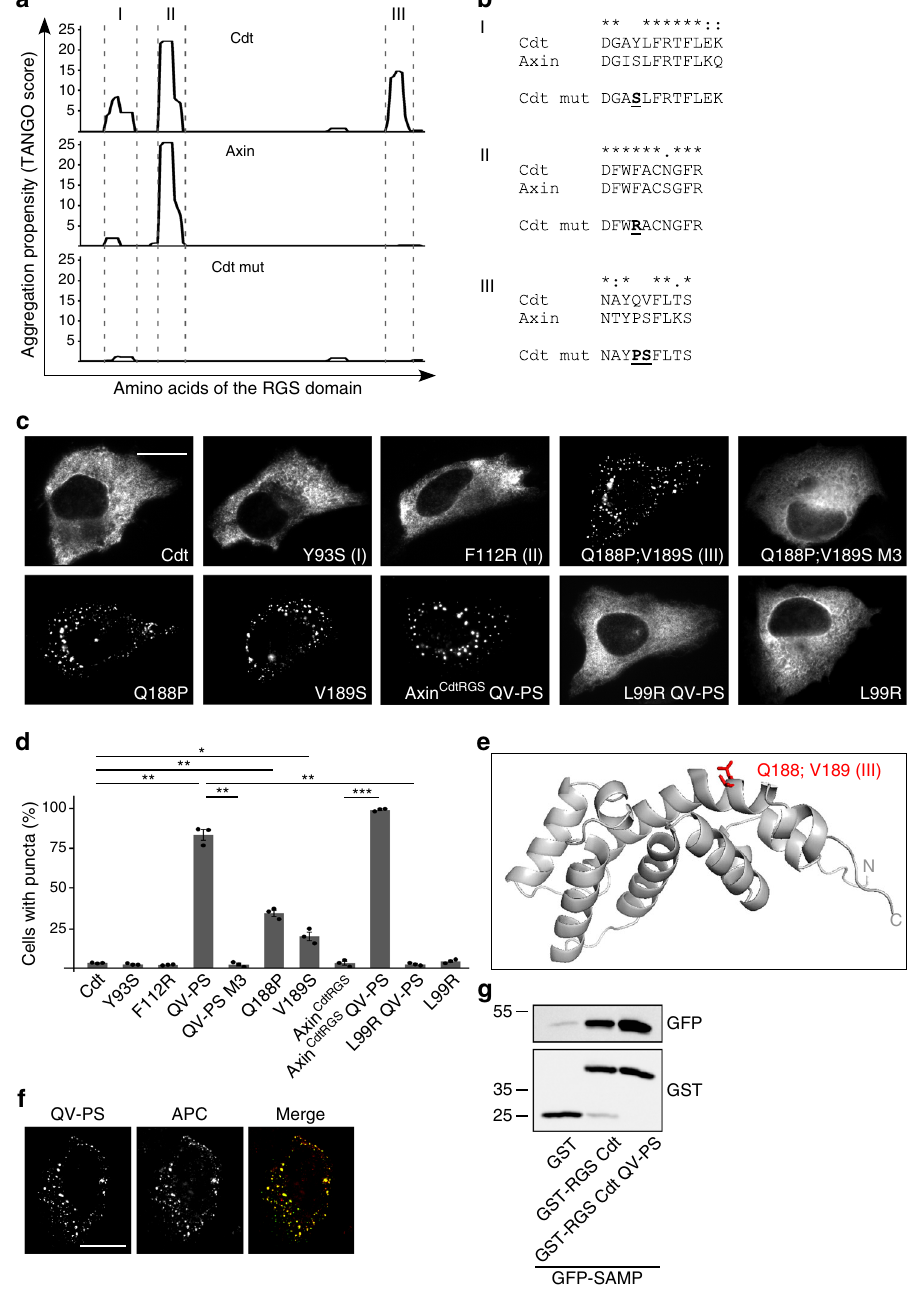
Fig. 2 An aggregation site within the RGS domain prevents conductin polymerization. a Aggregation propensity score calculated by the TANGO algorithm for amino acids in the RGS domains of conductin (Cdt), axin, and mutated conductin (Cdt mut). b Clustal Omega alignments of conductin and axin sequences for the three aggregation sites predicted in a . Identity (*) and conservation between amino acid groups of strongly (:) and weakly (.) similar properties are indicated 38 . Mutated key residues are highlighted. c GFP fl uorescence in U2OS cells transfected with indicated GFP-tagged constructs. Scale bar: 20 µ m. d Percentage of transfected cells showing puncta formation of indicated constructs. Per construct, 1500 cells of three independent experiments as in c were analyzed. Results are mean ± SEM ( n = 3). * p < 0.05, ** p < 0.01, *** p < 0.001 (Student ’ s t -test). e 3D structural model of the conductin RGS domain calculated by SWISS-MODEL using the crystal structure 1DK8 of the highly similar axin RGS domain (Fig. 1a) as a template 41,42 . The Global Model Quality Estimate (GMQE) reached 0.80. Amino acids mutated within aggregation site III are indicated in red. N- and C-terminus are labeled with N and C, respectively. f Immuno fl uorescence staining of APC (red) in U2OS cells transfected with GFP-tagged conductin QV-PS (green) together with APC. Scale bar: 20 µ m. g Western blotting for indicated proteins after GST-pull down from an extract of HEK293T cells expressing GFP-SAMP which was aliquoted and supplemented with equal amounts of either GST, GST-RGS Cdt, or GST-RGS Cdt QV-PS. Source data are provided as a Source Data fi